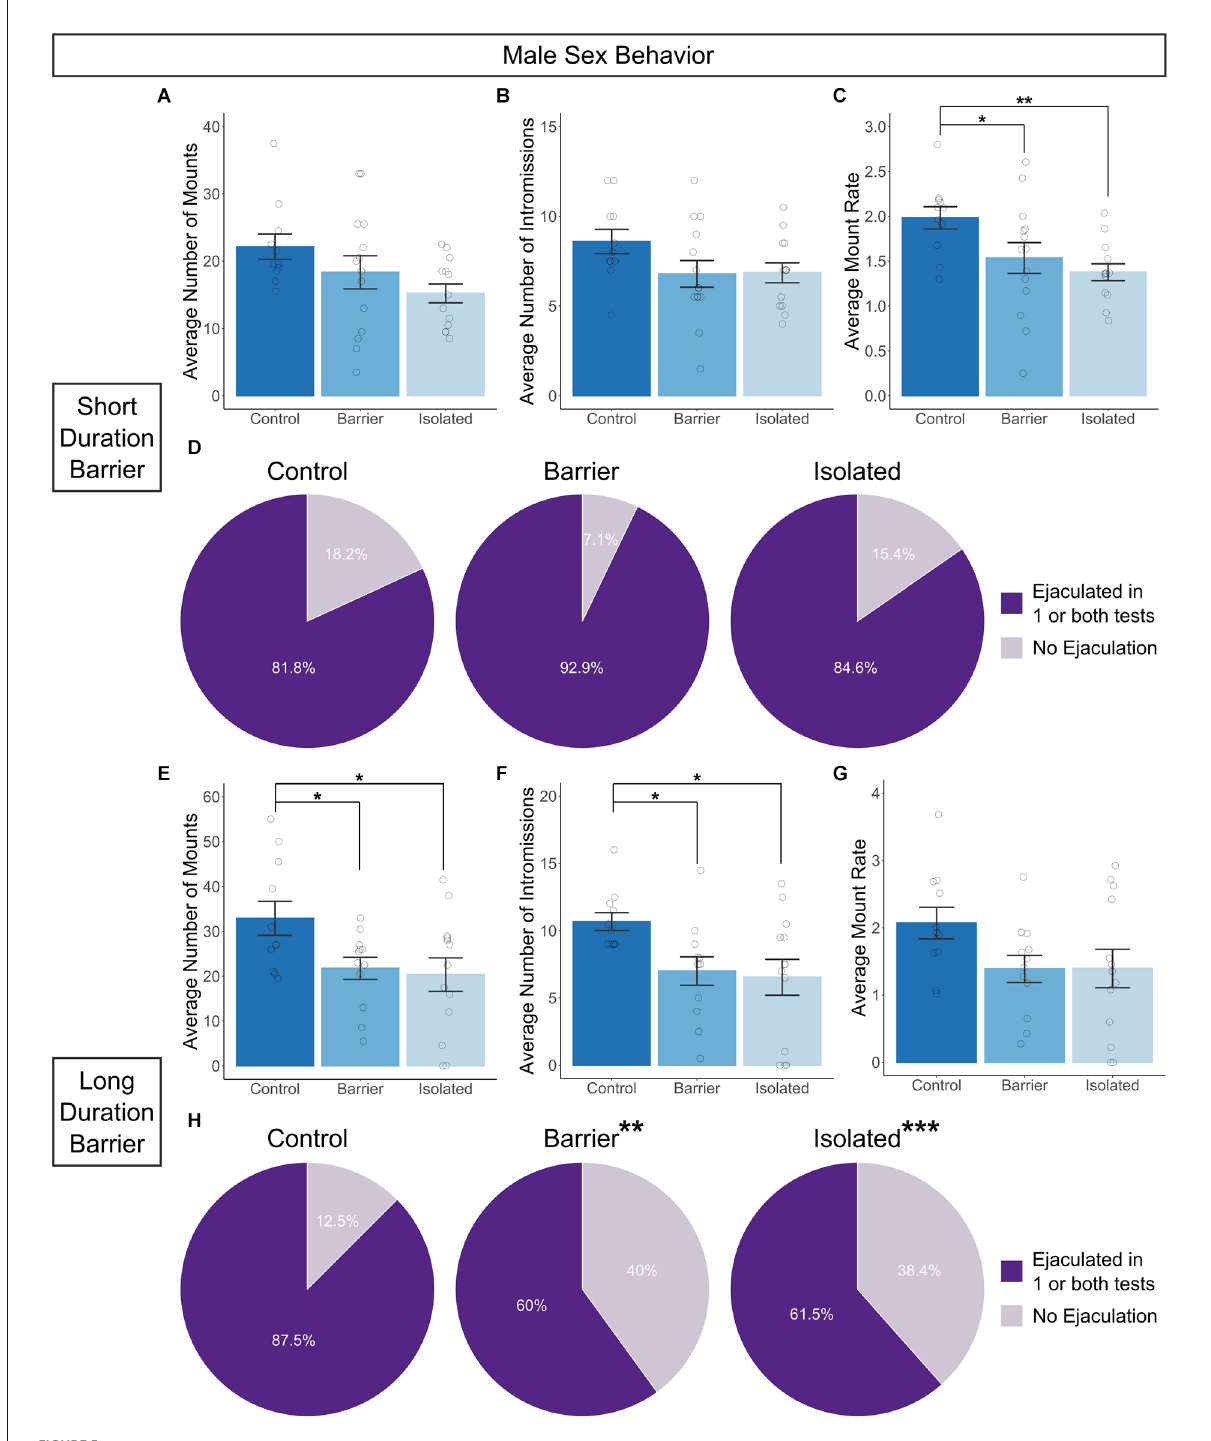
FIGURE5 Juvenile play deprivation induces deficits in adult male copulatory behavior. Quantification of the average number of mounts (A) , intromissions (B) , and the mount rate (C) , (the total number of all mounts, intromissions, and ejaculations divided by the active time, multiplied by 60 to indicate the number of mounts per minute) across two 10-min tests with a hormonally primed adult female stimulus rat on P63 and P70 in the short duration barrier experiment. The same measures are shown in (E–G) for the long duration barrier experiment. Panels (D,H) indicate the proportion of animals in each group which ejaculated on one or both tests. Bars indicate group means ± SEM, and open circles represent data from individual rats. * p < 0.05, ** p < 0.01, n = 8–14 per group. In (H) , ** and ***indicate that the proportion of animals which ejaculated is significantly different (** p < 0.01, *** p < 0.001) from 90%, the amount expected for control animals based on historical